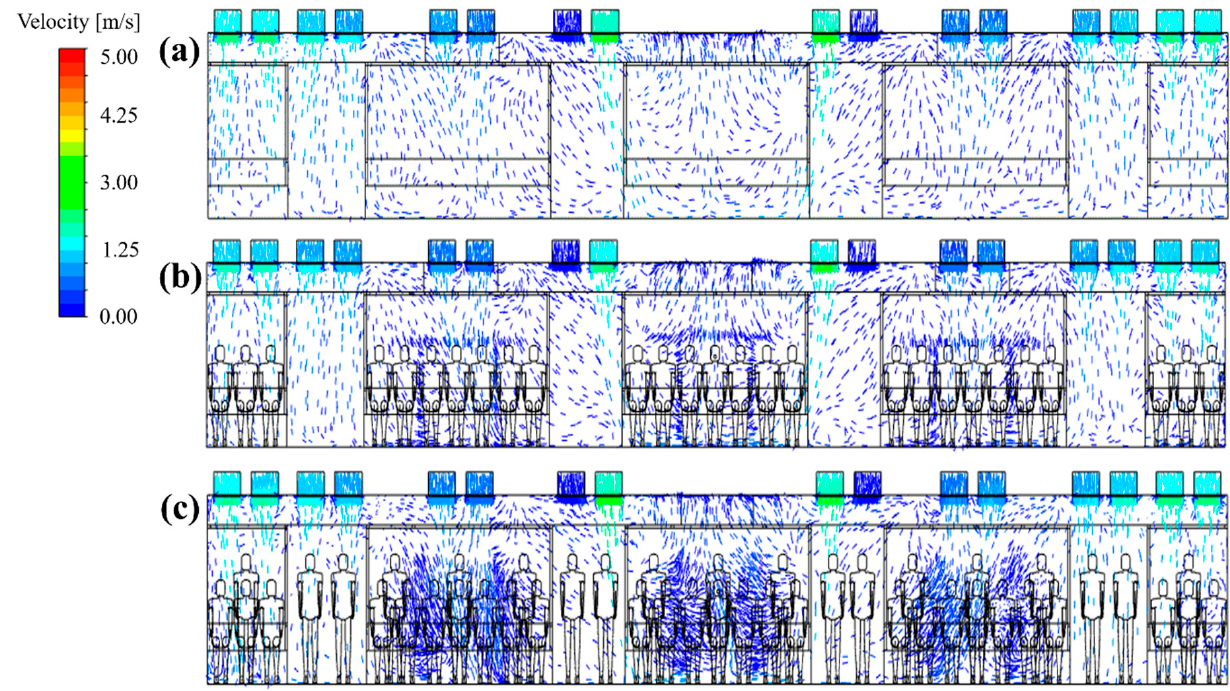
Figure 5. Airflow velocity vectors in the central section of the cabin according to the number of passengers (total ventilation flow rate: 500 CMH). ( a ) No people; ( b ) 51 people (all seated); and ( c ) 88 people (51 seated and 37 standing).